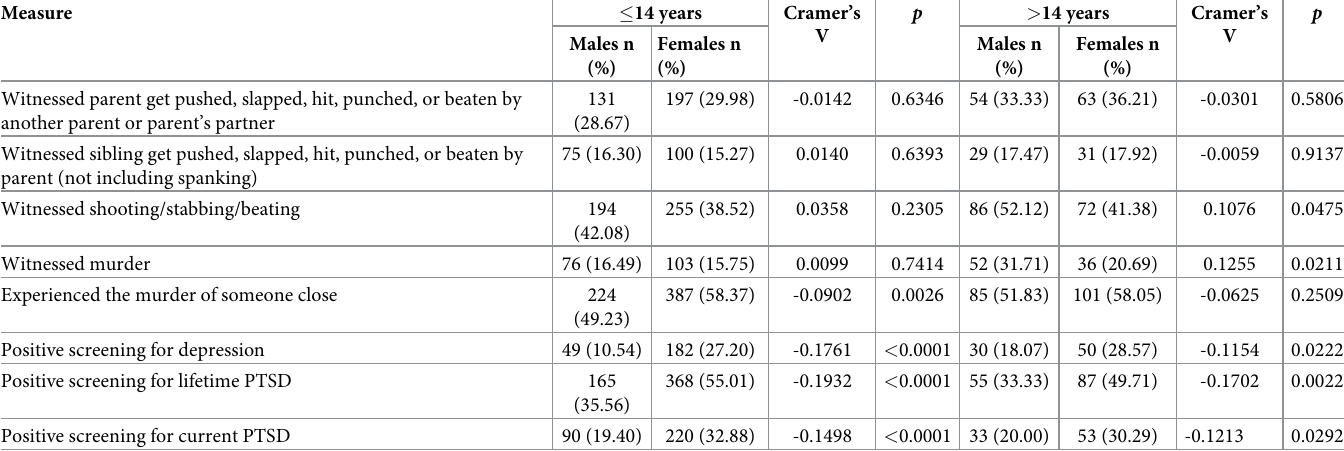
Table 5. Indirect exposure to violence and adverse mental health symptomatology among younger ( � 14 years) and older ( > 14 years) youth, by gender (N = 1548). Measure � 14